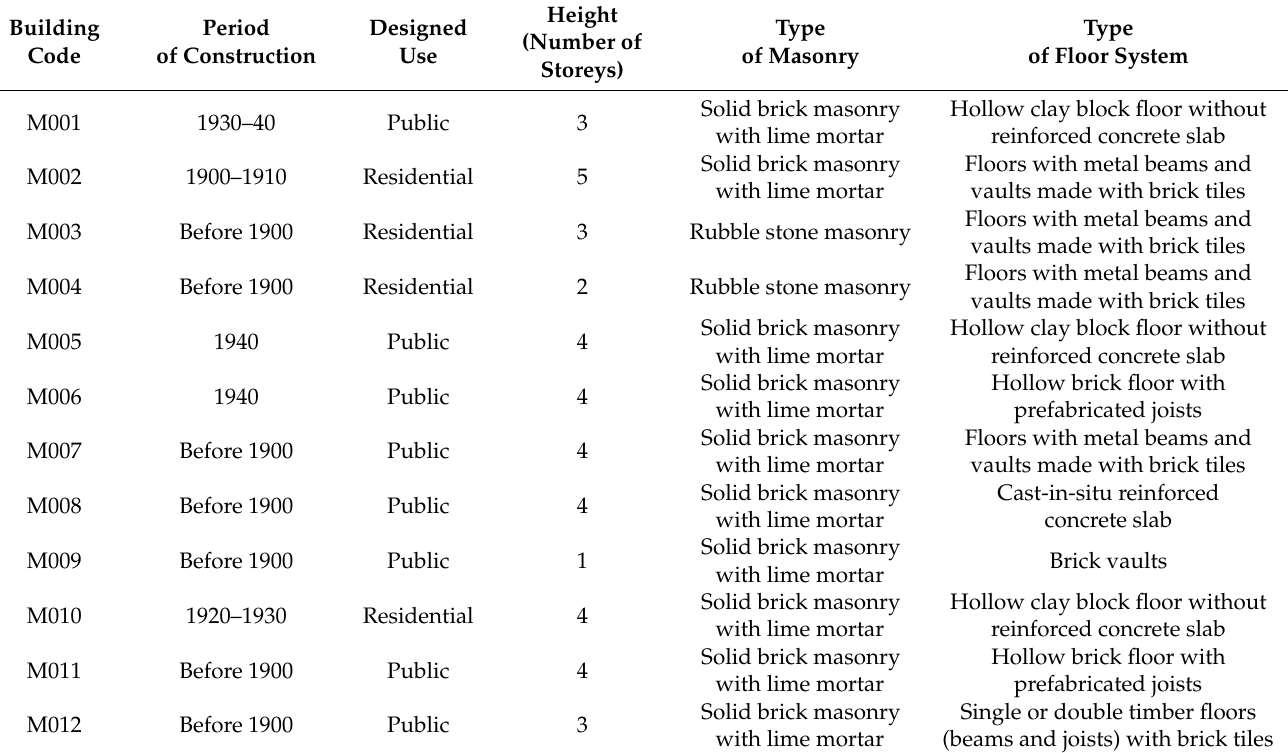
Table A7. Main characteristics of the sample